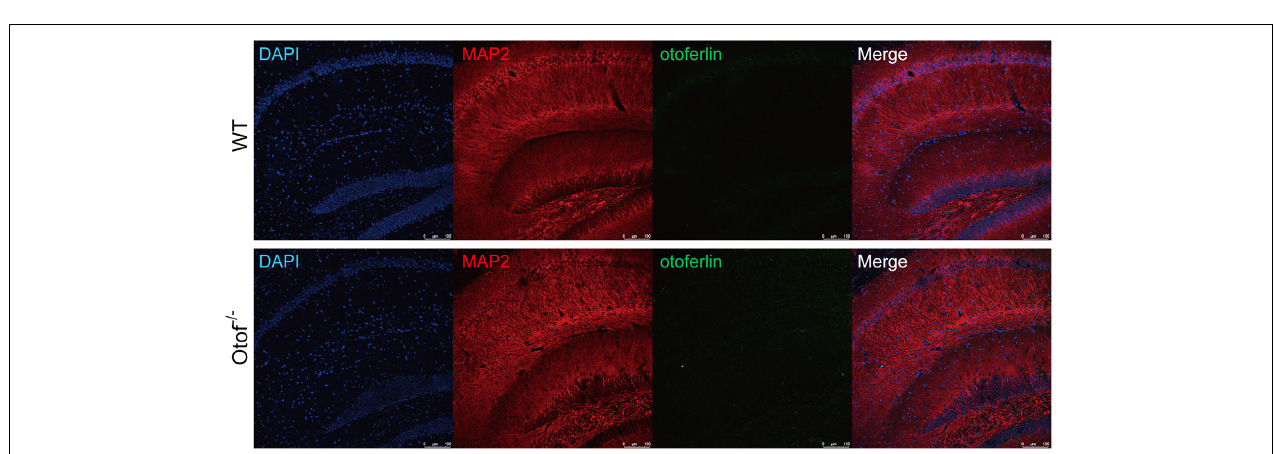
FIGURE 7 | Otoferlin staining in the hippocampus of WT and Otof − / − mice. Immunofluorescence of WT and Otof − / − hippocampus slices with otoferlin (green), MAP2 (red), and DAPI (blue). WT, wild-type mice; Otof − / − , otoferlin knockout mice. Scale bars: 100 µ